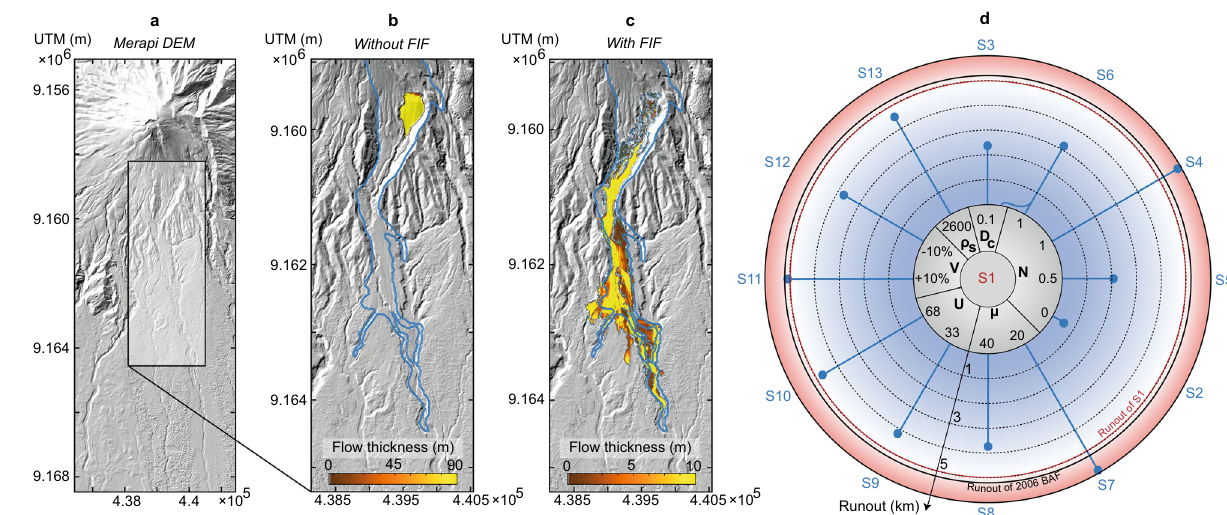
Fig.4|Theroleoffragmentation-induced fl uidisationinenhancingtherunout of fl uidisation N =0 ( b ) and N =0.8 ( c ), basal friction angle µ = 30°, initial velocity of pyroclastic density currents. a Digital elevation model (DEM) of Merapi vol- U =45m/s, bulk volume V =6×10 6 m 3 . The outline in blue depicts the deposit outlineoftheJune142006BAFatMerapithatencompassesboththeconcentrated cano prior to the June 2006 eruption. Depth-averaged model results showing the fl ow and the ash-cloud surge extent. The colour bar shows the simulated fl ow runout of the BAF mixture across the Merapi topography with and without thickness in metres. d Diagram showing the sensitivity of the fl ow runout to initial fragmentation-induced fl uidisation. b , c VolcFlowmodelresultswithout( b ,S2)and parameters. In each simulation one parameter was modi fi ed from the reference with ( c , S1) fragmentation-induced fl uidisation. Parameters used: particle density − 3 (SupplementaryFig.3,diffusioncoef fi cient D − 1 ,degree ρ case shown in c . All UTM coordinates in fi gures a, b and c are in s =2800kgm c =0.01m 2 s